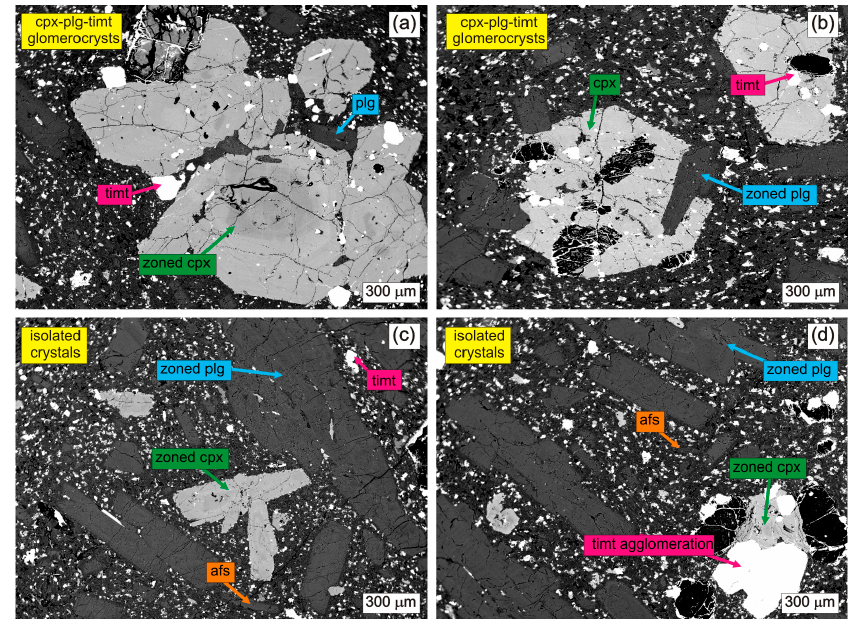
Figure 2. Petrographic features observed for the sill samples and evidencing the occurrence of either glomerocrysts ( a , b ) of clinopyroxene, plagioclase and titanomagnetite or isolated crystals ( c , d ). Clinopyroxene and plagioclase are normally zoned, whereas large titanomagnetite phenocrysts form by the attachment and agglomeration of smaller crystals. Alkali feldspar occurs only as microphenocryst. Cpx, clinopyroxene. Plg, plagioclase. Afs, alkali feldspar. Timt, titanomagnetite.